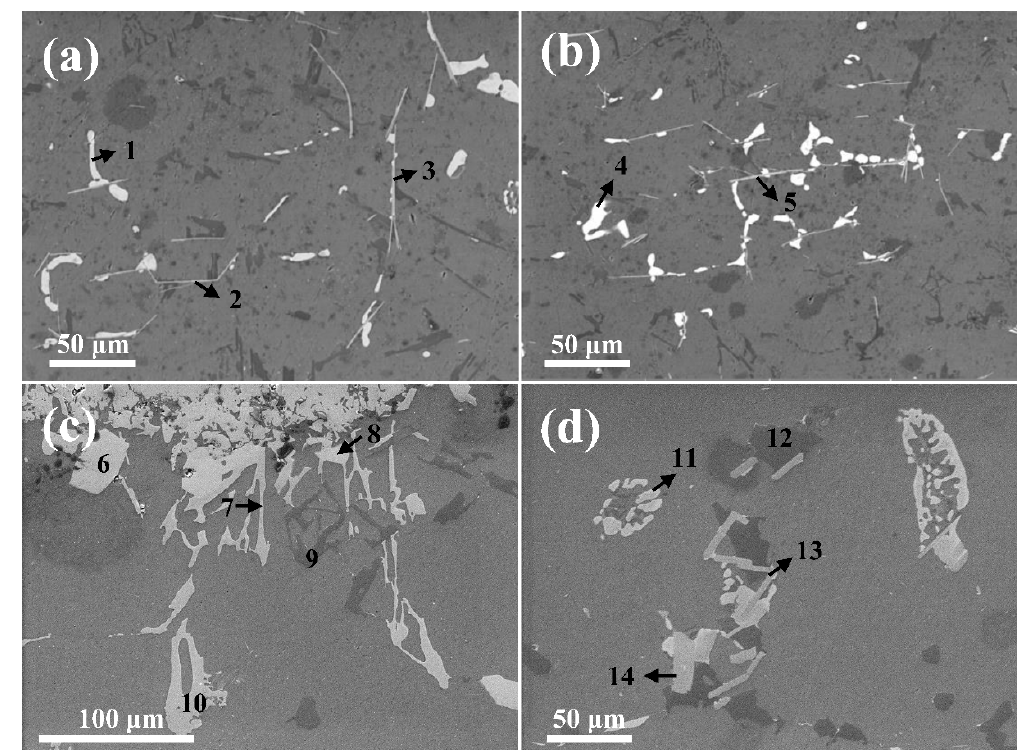
Figure 5. SEM micrographs of the intermetallic phases in the Al matrix according to distance from the interface under as-cast and 550 ℃ heat treatment conditions; ( a ) as-cast (near interface), ( b ) as-cast (far from interface), ( c ) 550 °C heat treatment (near interface), and ( d ) 550 °C heat treatment (far from interface).